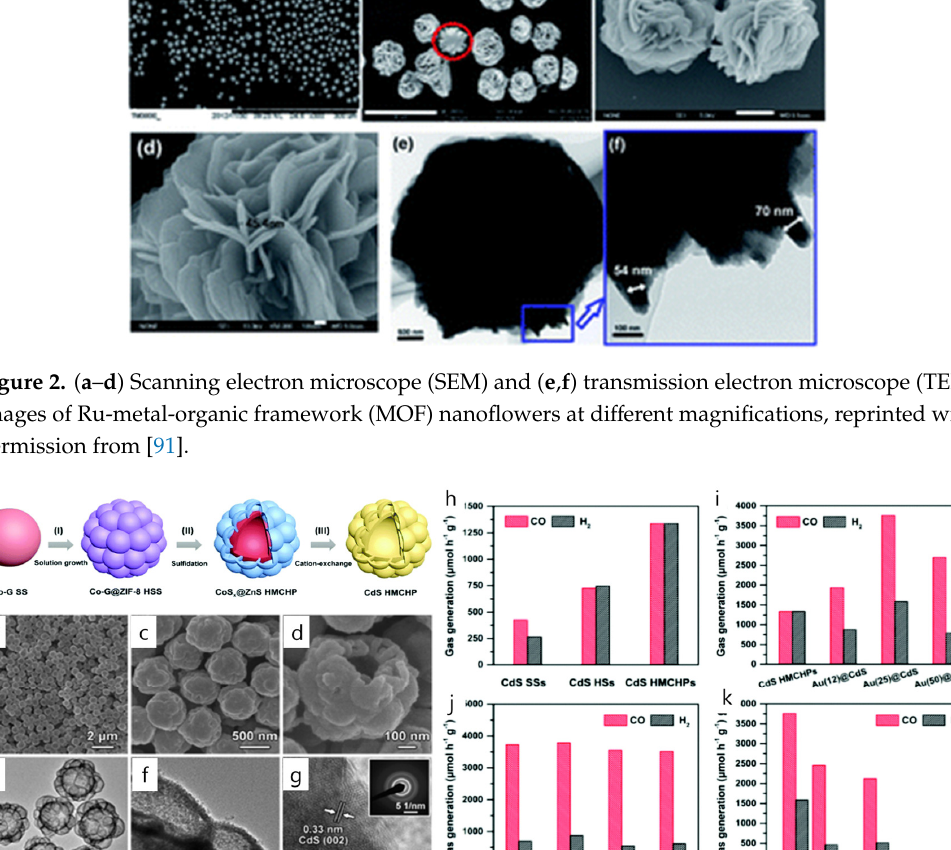
Figure 3. (a) Stepwise formation process of CdS hierarchical multi ‐ cavity hollow particles (HMCHPs), Figure 3. ( a ) Stepwise formation process of CdS hierarchical multi-cavity hollow particles